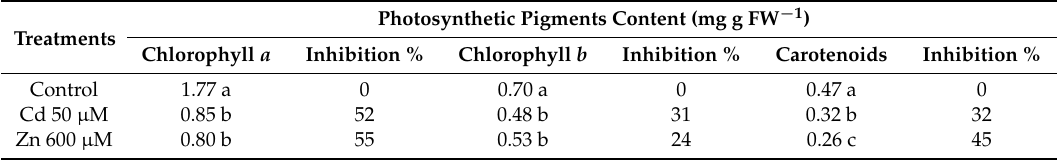
Table 2. Effects of Cd and Zn on photosynthetic pigments content in durum wheat